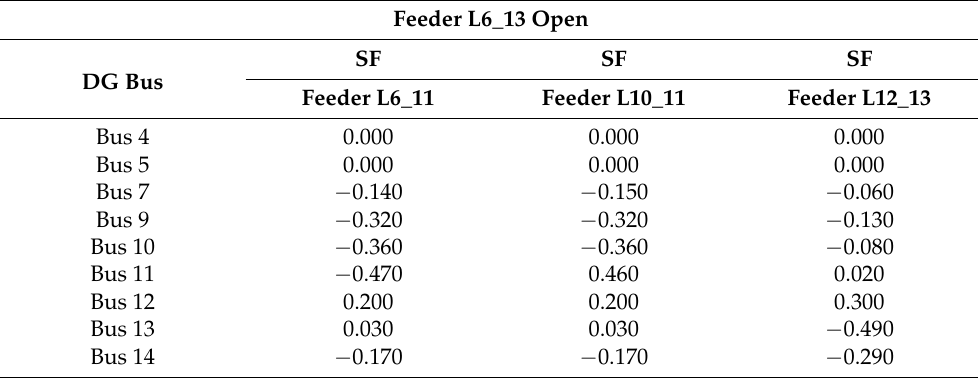
Table 3. Sensitivity factor for 1 MW DG placed at various buses.